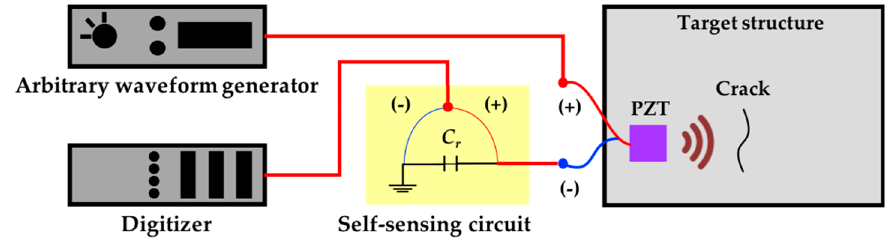
Figure 5. Schematic design of the self-sensing nonlinear ultrasonic system.